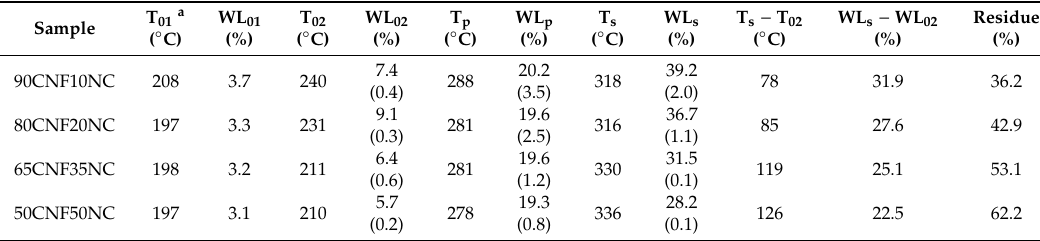
Table 3. Decomposition characteristic parameters of CNF / NC